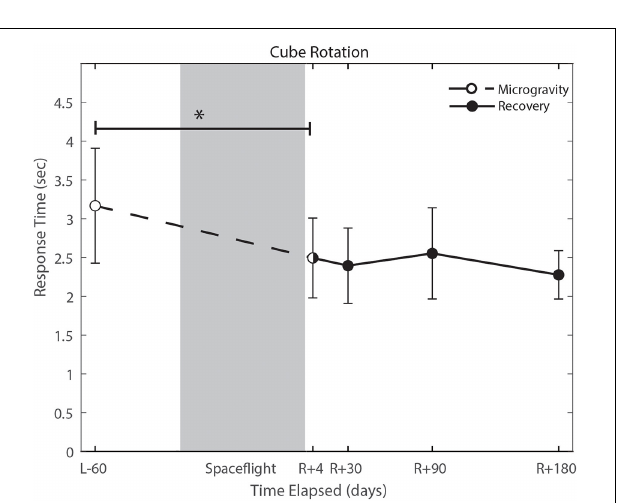
FIGURE 3 | Balance (SOT-5) changes from pre- to post-flight and post-flight recovery. The Sensory Organization Task 5 (SOT-5) performance changes indicate that the microgravity environment resulted in a significant decrease in Equilibrium Score ( p = 0.01), that did not show statistically significant recovery. *Indicates statistical results that are p < 0.05.